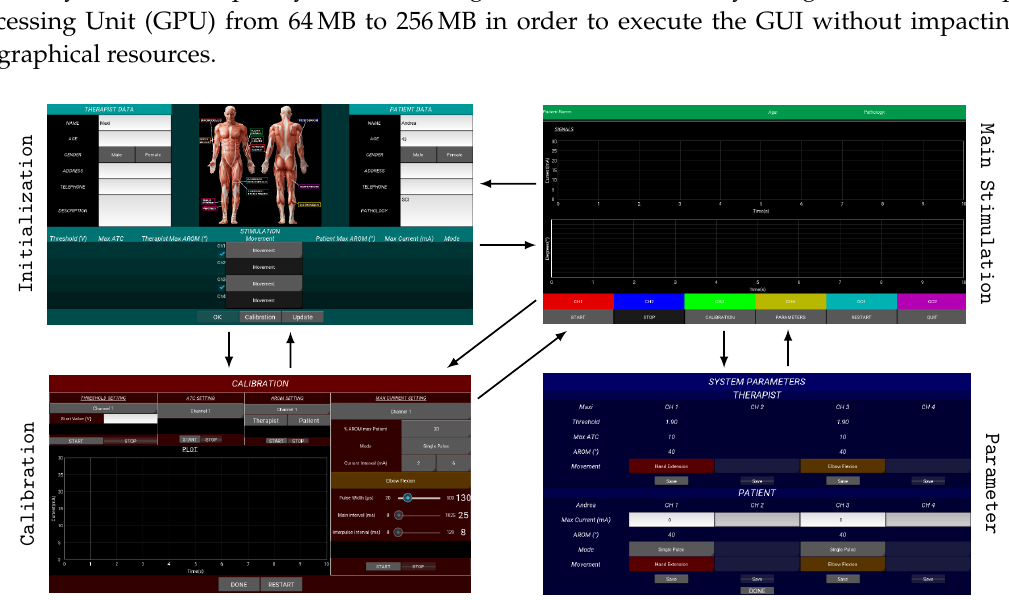
Figure 7. Kivy main screens: The Initialization one allows the user to store subjects information and set up the system; in the Calibration one the calibration process is achieved, and the optimized parameters can be visualized, saved and modified into the Parameter screen; finally, the Main Stimulation screen runs the stimulation and graphically represents the signals of interest. Arrows highlight transitions among